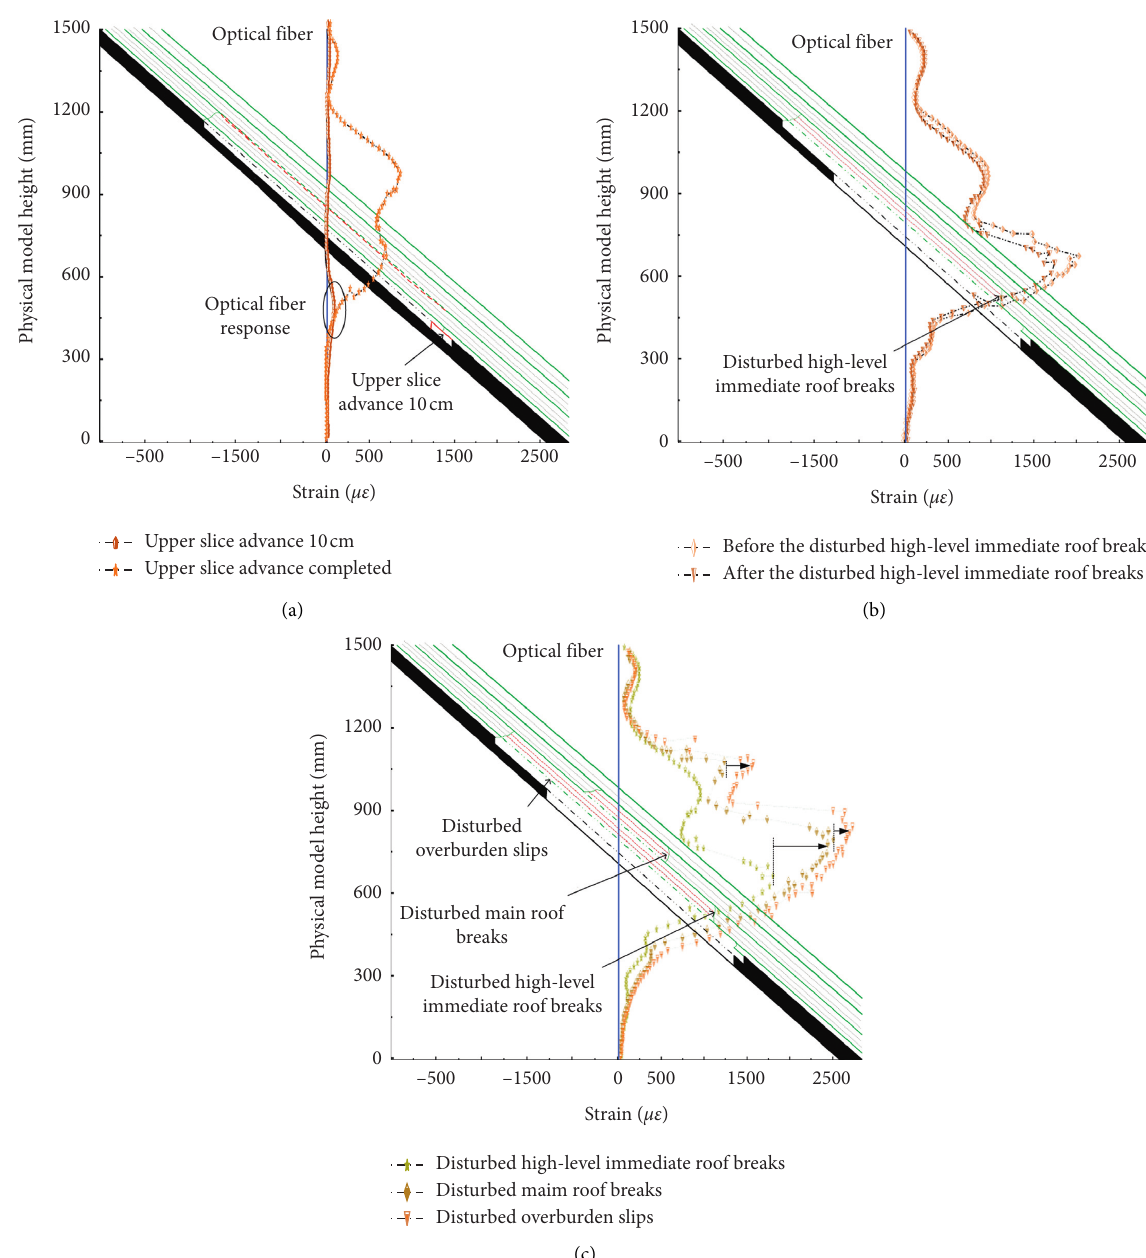
Figure 8: Roof fall fiber response characteristics: (a) Upper slice recovery fiber response, (b) disturbed high-level immediate roof rupture fiber response, and (c) rock rupture in the lower strata in different regions of fiber